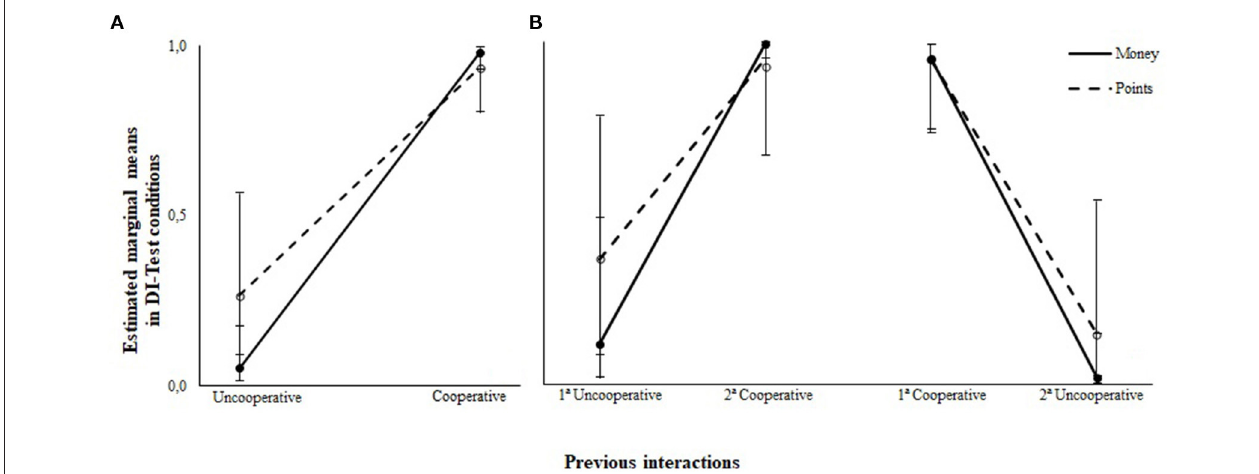
FIGURE 4 | Estimated marginal means of participant’s blue cards choices under disadvantageous inequity test conditions as a function of previews interactions with cooperative and uncooperative computer. (A) Depicts participants aggregated data for proportion of blue choices, showing that computer choices prior to DI-Test directly affected participants’ choices. (B) Depicts participants proportion of choices of blue card in each DI-Test, showing that prior interactions directly affected participants’ choices in DI-Test conditions regardless of the order of exposition.